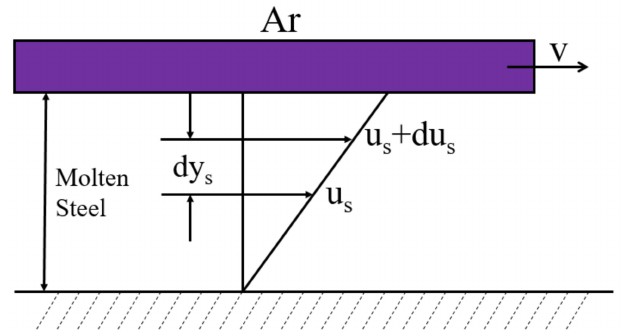
Figure 10. Schematic diagram of the interaction between argon and molten